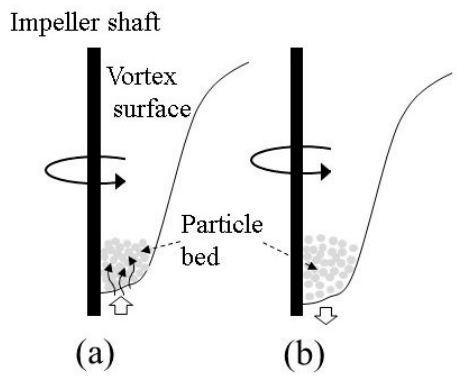
Figure 9. A schematic representation of the particle behavior at the bottom of the vortex during the surface oscillations. The surface moves ( a ) upward and ( b ) downward.